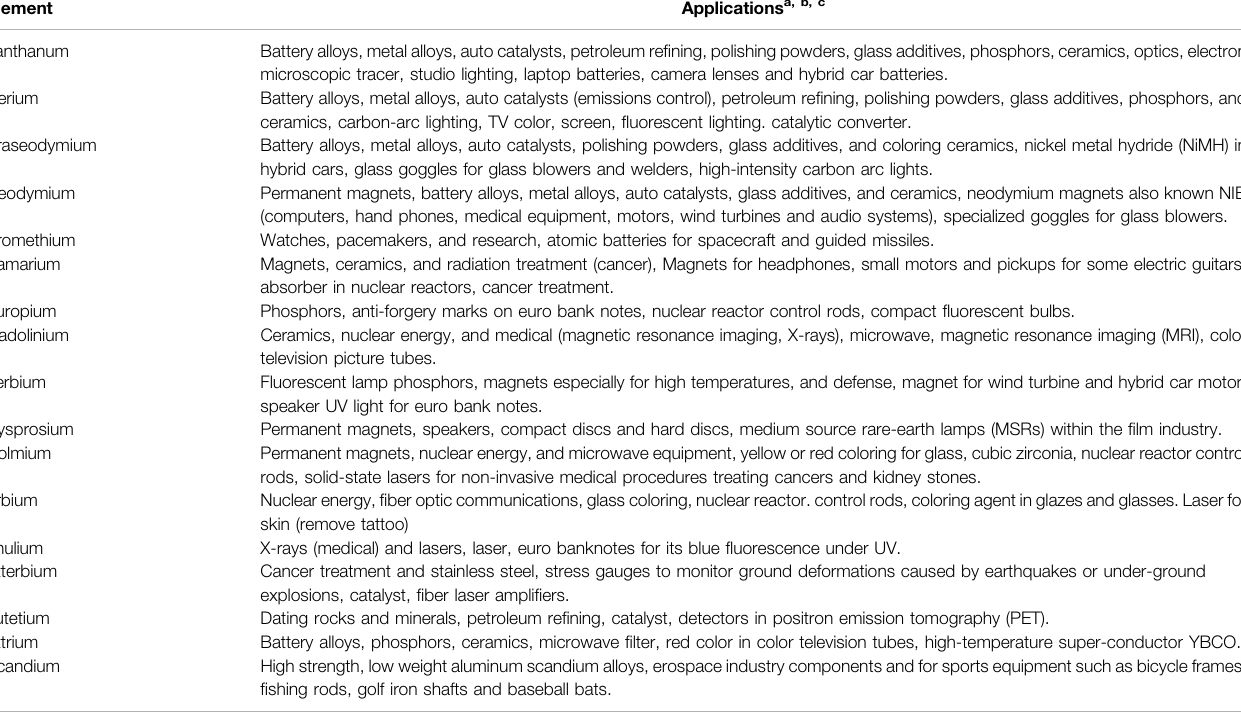
TABLE 1 | Main application of rare earth. Element Applications a, b,